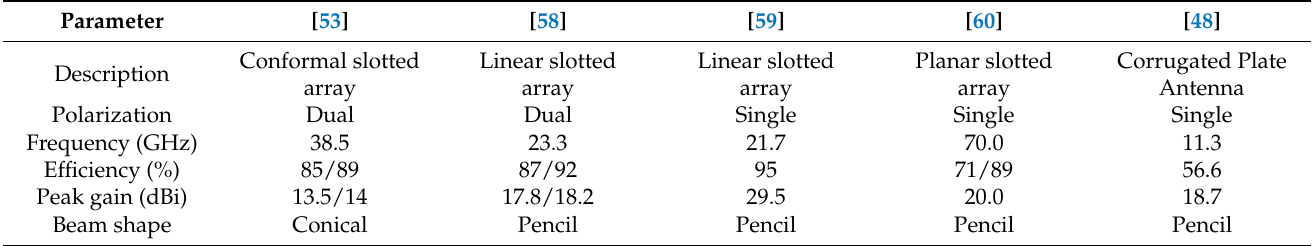
Table 4. Comparison of high-gain antenna designs manufactured by SLA